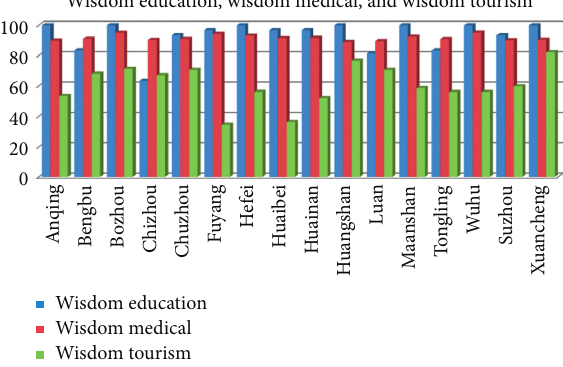
Figure 11: Wisdom education, wisdom medical, and wisdom tourism.